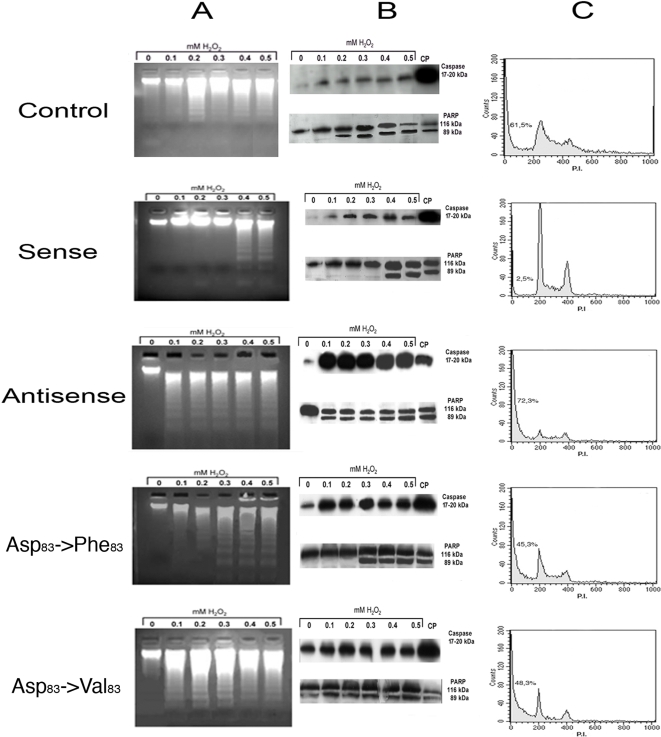
Effect of PCMT expression levels and mutants on apoptosis induced by oxidative stress on PAE cells.Column A: Apoptotic DNA ladder in cells overexpressing PCMT constructs and subject to oxidative treatment. Apoptotic DNA ladder patterns, of transfected endothelial cells stimulated with different concentrations of H2O2, were detected after transfection with plasmid void (control) or carrying PCMT wild type (sense); antisense PCMT; PCMT Asp83 →Phe83 Mut and PCMT Asp83 →Val83 Mut. Column B: Caspase-3 activation and PARP cleavage in cells overexpressing PCMT constructs and subject to oxidative treatment. Immunoblot developed with a polyclonal antibody against caspase-3 and PARP (a final effector of various apoptotic pathways) on transfected endothelial cells stimulated with different concentration of H2O2 after transfection with plasmid void (control) or carring PCMT wild type (sense), antisense PCMT, PCMT Asp83 →Phe83 Mut and PCMT Asp83 →Val83 Mut. CP is a positive control obtained by treating a parallel cell sample with cisplatin. Column C: Flow cytometry analysis of cells overexpressing PCMT constructs and subject to oxidative treatment. Cells stimulated with 0.3 mM of H2O2 after transfection with void plasmid (control), PCMT wild type (sense), Antisense PCMT, PCMT Asp83 →Phe83 Mut. PCMT Asp83 →Val83 Mut. PI: propidium iodide.